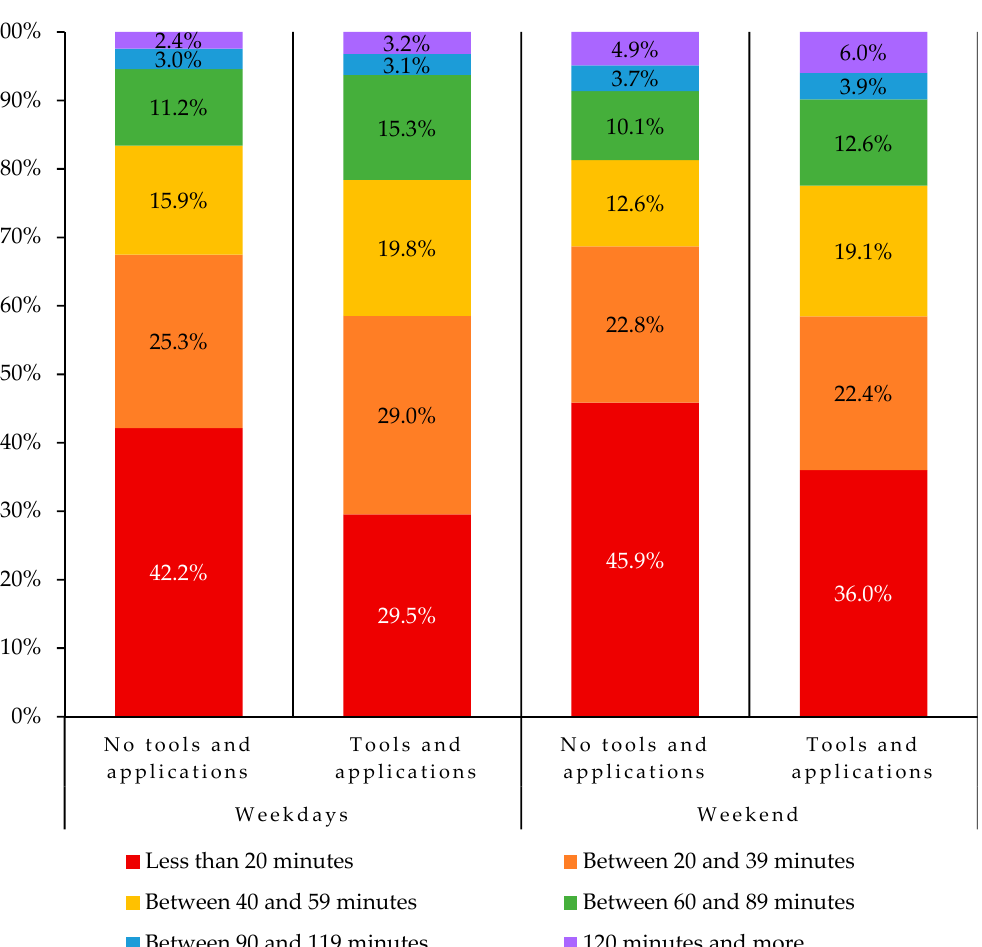
Figure 6. Association between the use of physical activity-related tools and applications and the daily physical activity in adolescents. Pearson chi square p value < 0.001 for this association on both weekdays and weekend.